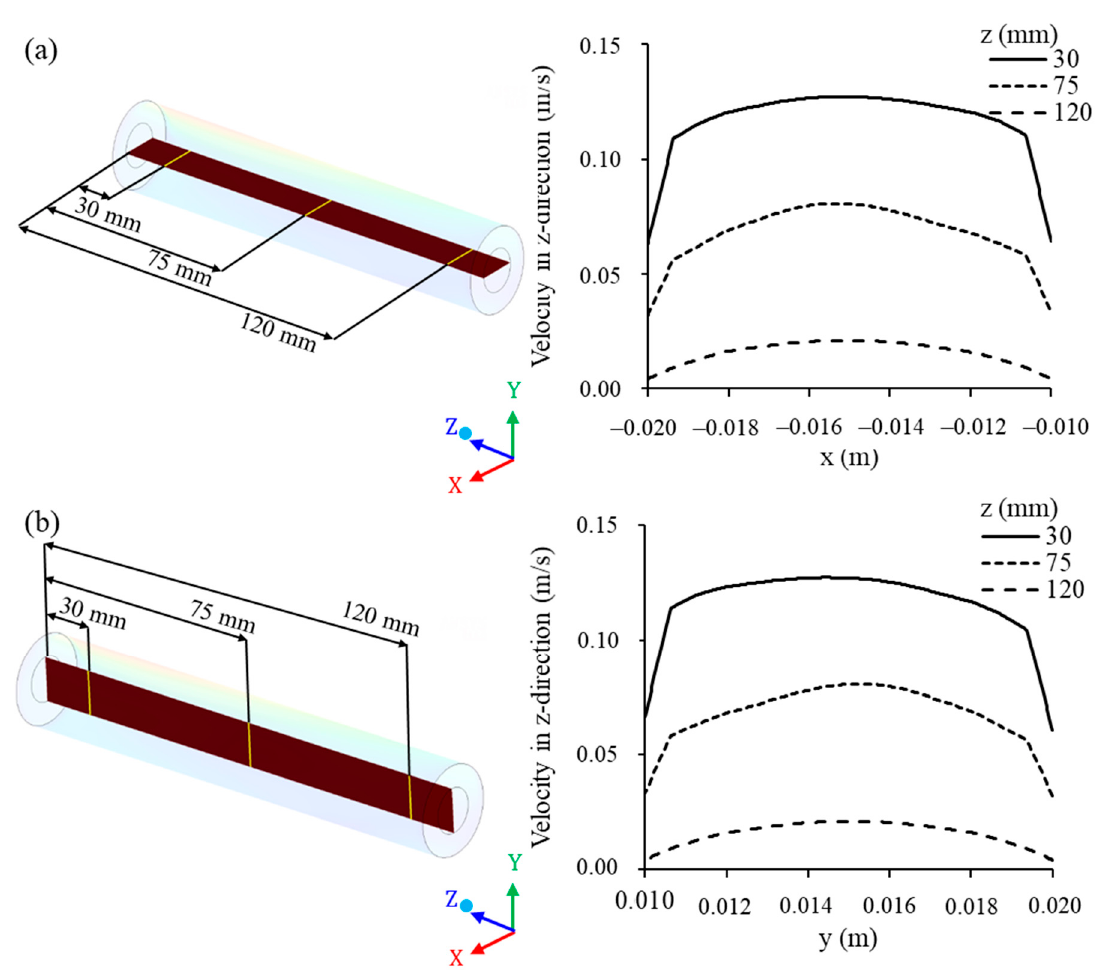
Figure 15. Axial permeate velocity at different ( a ) horizontal and ( b ) vertical points along the membrane collecting tube, at z = 30, 75, and 120 mm, of the filtration module during the water/oil separation process.